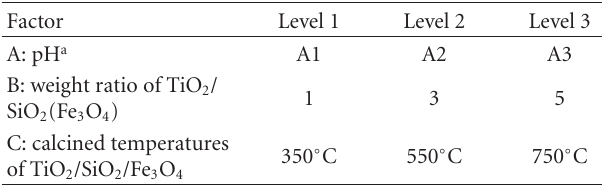
Table 1: E ff ect of calcinations temperature on reaction rate con- stant and surface area.